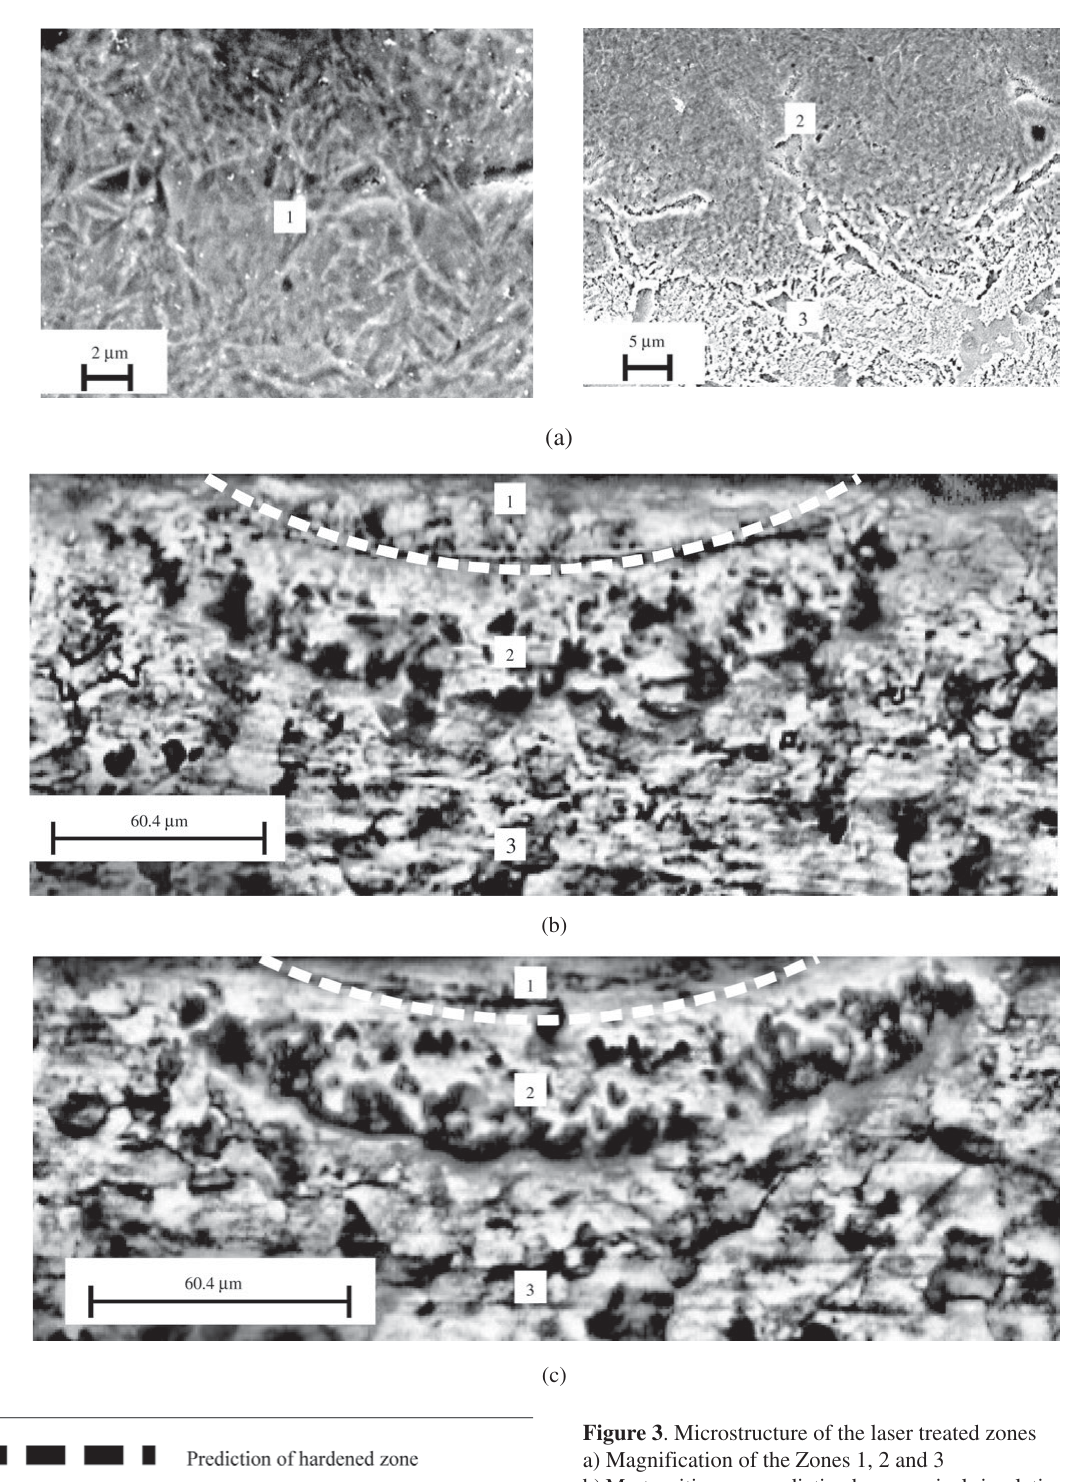
Figure 3 . Microstructure of the laser treated zones a) Magnification of the Zones 1, 2 and 3 b) Martensitic zone prediction by numerical simulation - laser scan speed= 2.67 × 10 -1 m/s; c) Martensitic zone prediction by numerical simulation - laser scan speed= 3 × 10 -1